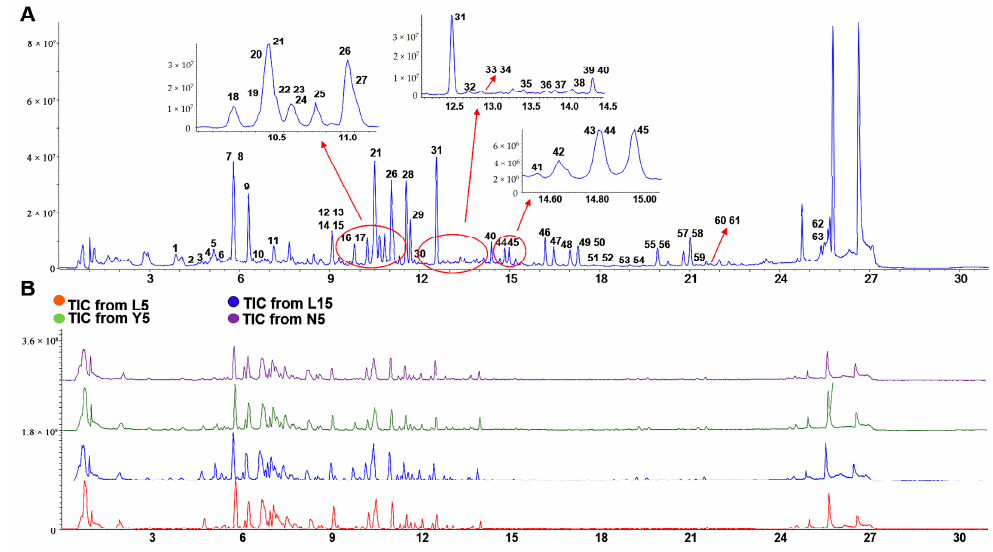
Figure 4. TIC of the ginseng standard references and four ginseng samples. ( A ) TIC of the ginseng standard references. ( B ) TIC of the four ginseng samples.